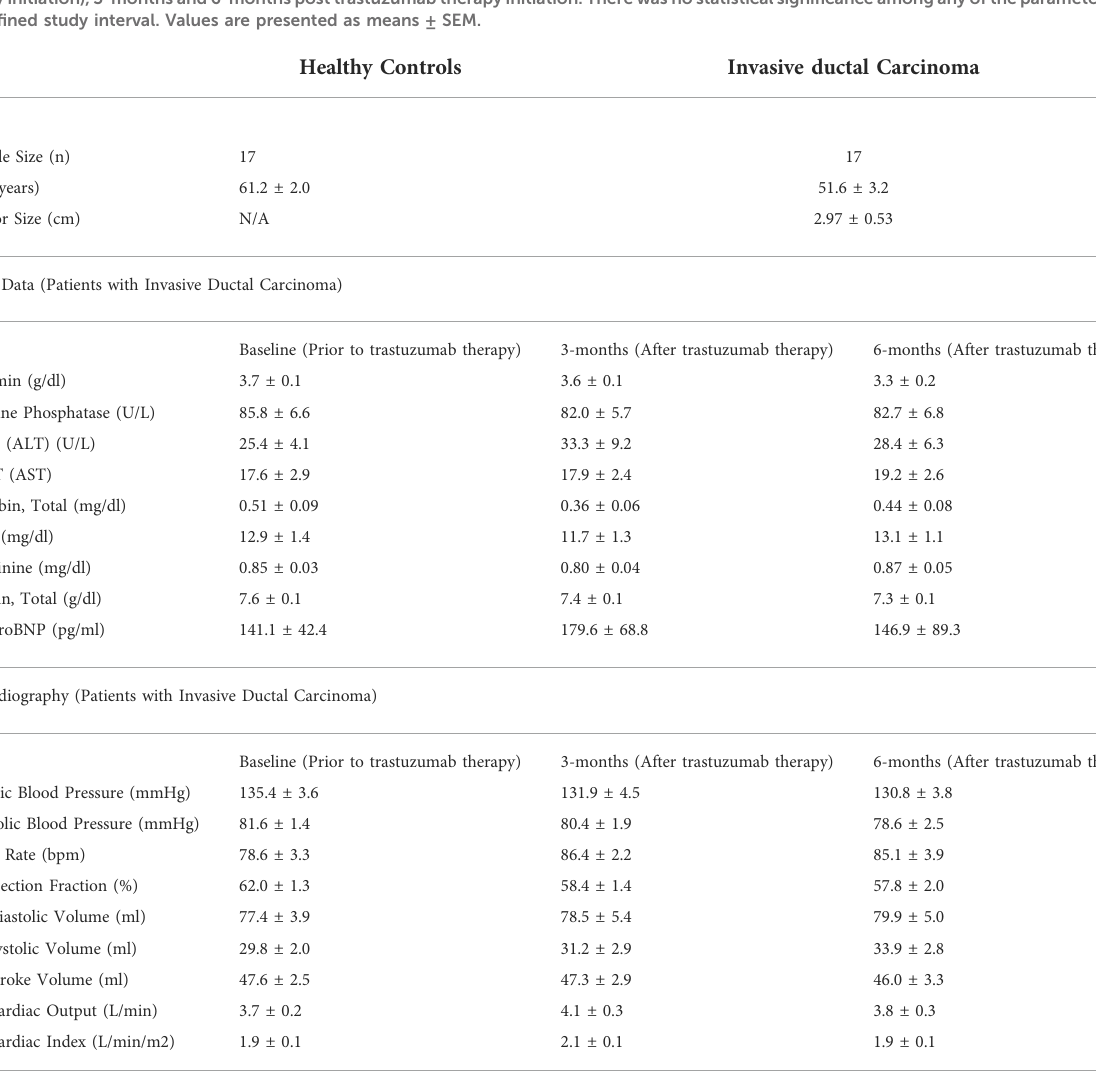
TABLE 1 Summary of patient demographics, clinical parameters, and echocardiography measurements. This table provides demographics of the study subjects including their clinical pro fi le and echocardiography measurements at each study interval of baseline (prior to